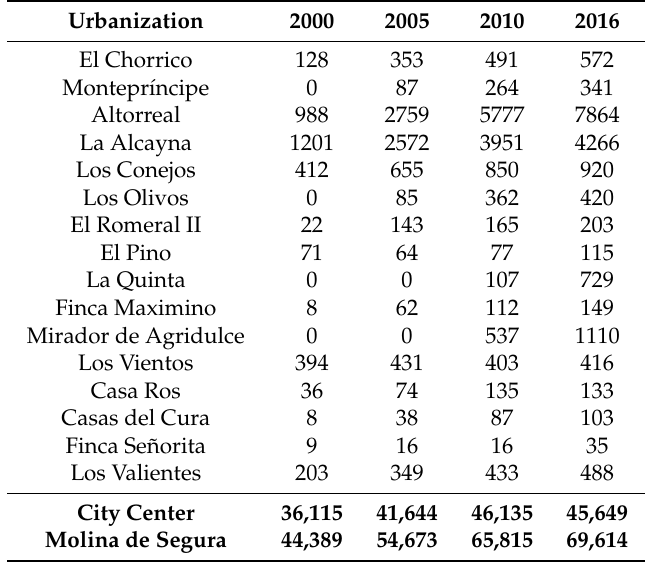
Table 1. Demographic evolution (2000–2016) of urbanizations of Molina de Segura (No. of people). Urbanization